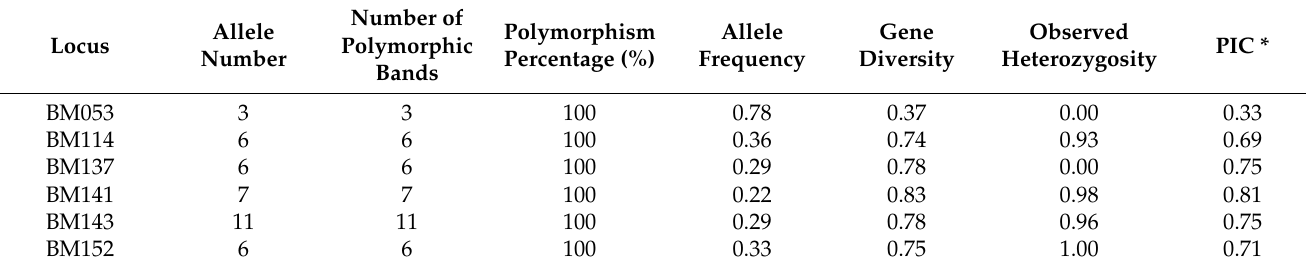
Table 3. Summary information obtained with twenty-seven 27 SSR primer pairs used in bean accessions collected from ˙Ispir